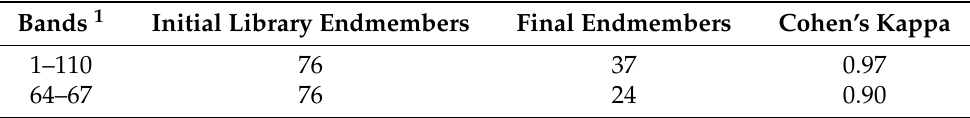
Table 5. IES results show library endmember reduction and Cohen kappa coefficients for the 4-band and 110-band spectral libraries.